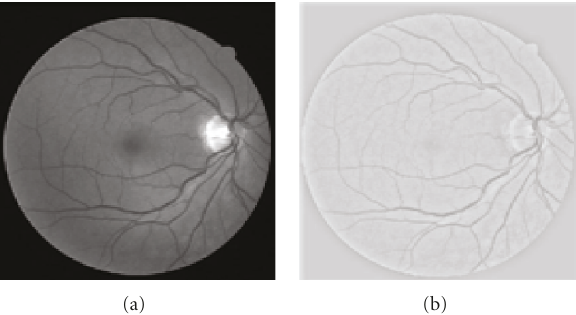
Figure 7: Local contrast enhanced image.